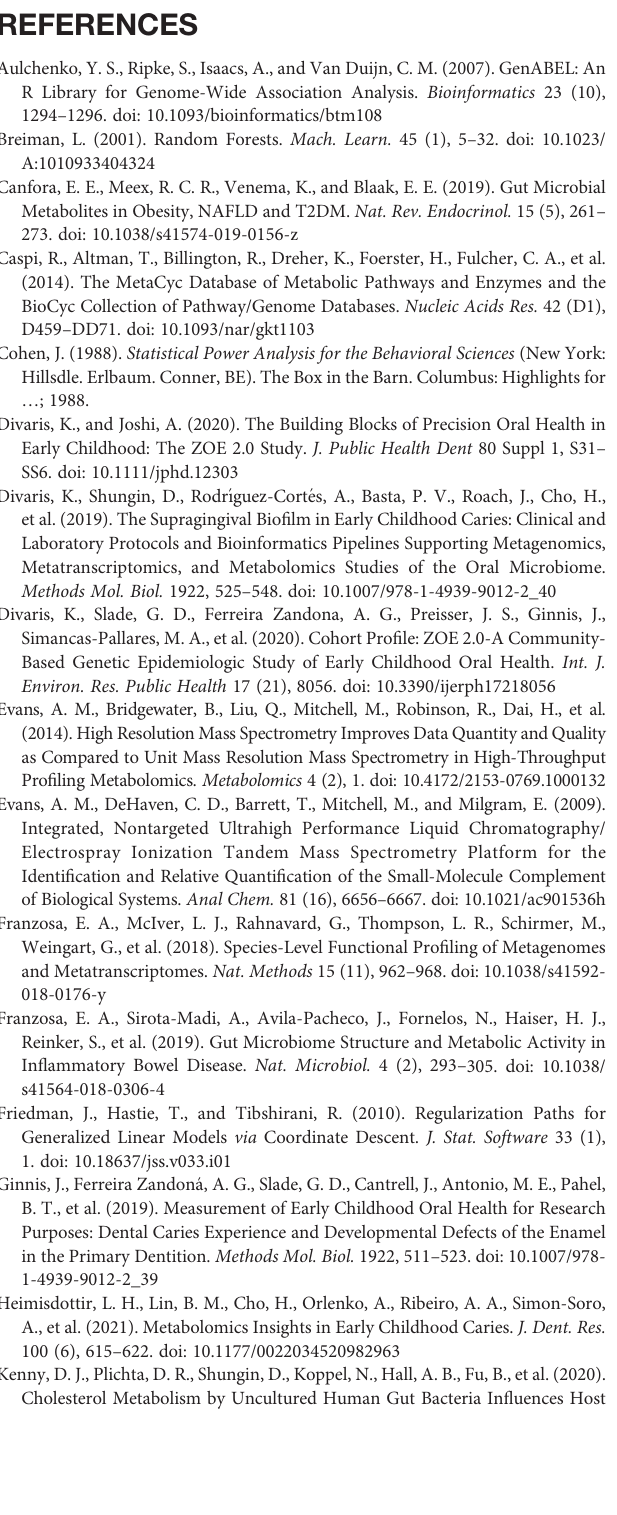
Supplementary Table 2 | The gene lists in DNA or RNA, based on the highest rank or the average rank among metabolites, that contribute to prediction of well-